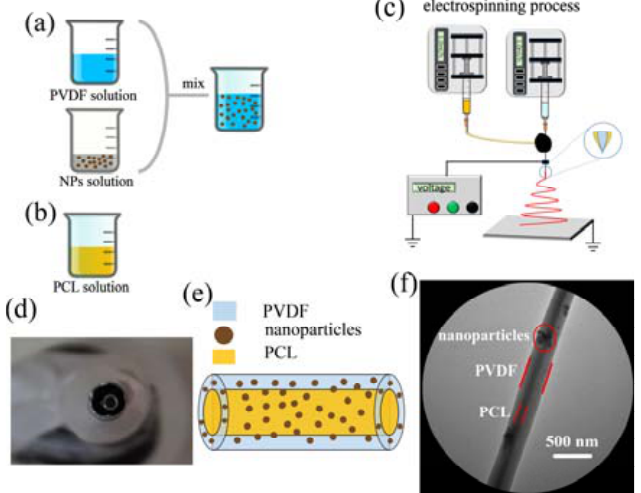
Figure 1. Schematic illustration of the electrospinning process. ( a ) NPs-PVDF solution. ( b ) PCL solution. ( c ) Electrospinning setup. ( d ) Homemade coaxial electrospinning needle. ( e ) Illustration of core-sheath structure fi ber. ( f ) TEM image of core-sheath fi bers.